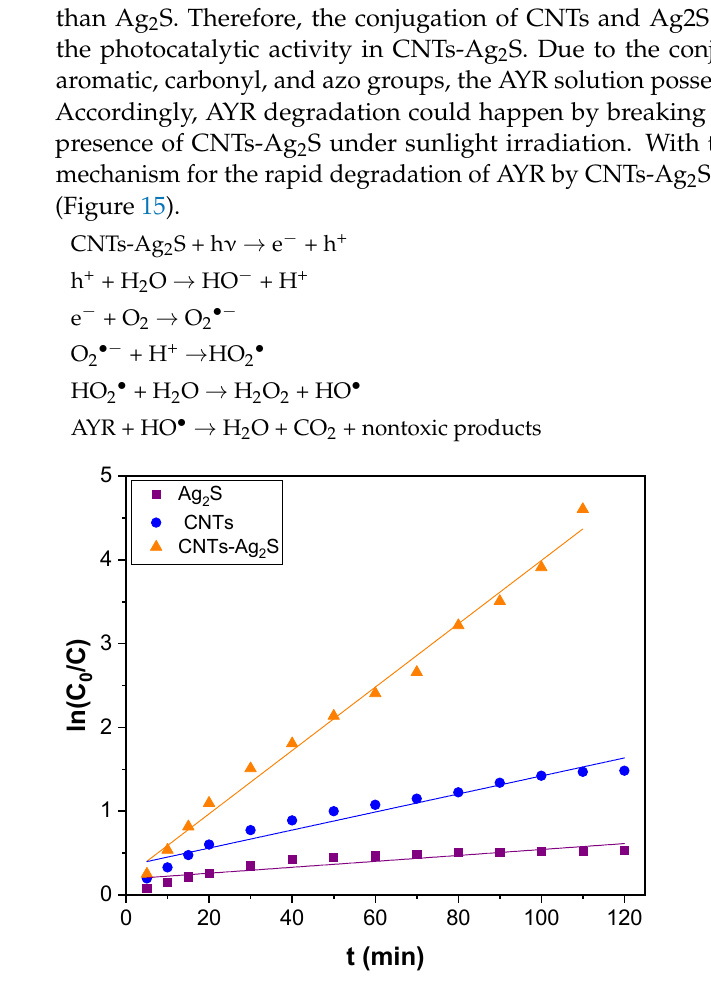
Figure 14. Langmuir-Hinshelwood plot for the degradation of alizarin yellow R in the presence of CNTs-Ag 2 S under illumination to sunlight.